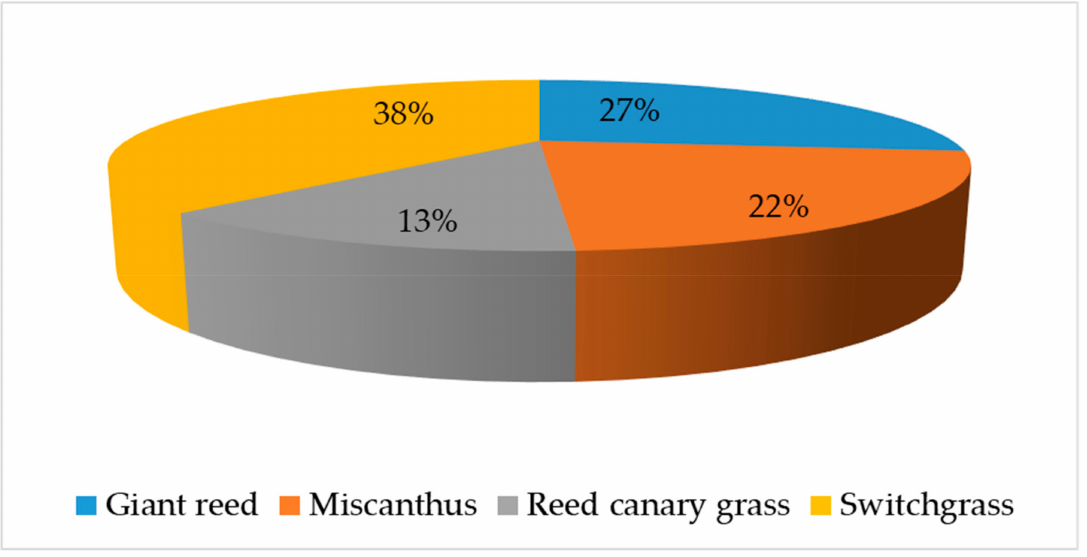
Figure 1. Percentage of papers per species dealing with mechanical harvesting identified after systematic literature